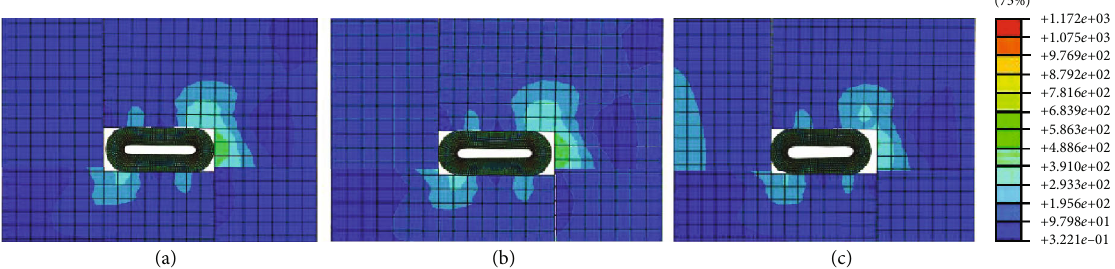
Figure 10: Compression equivalent stress for metal tubes displaced at di ff erent